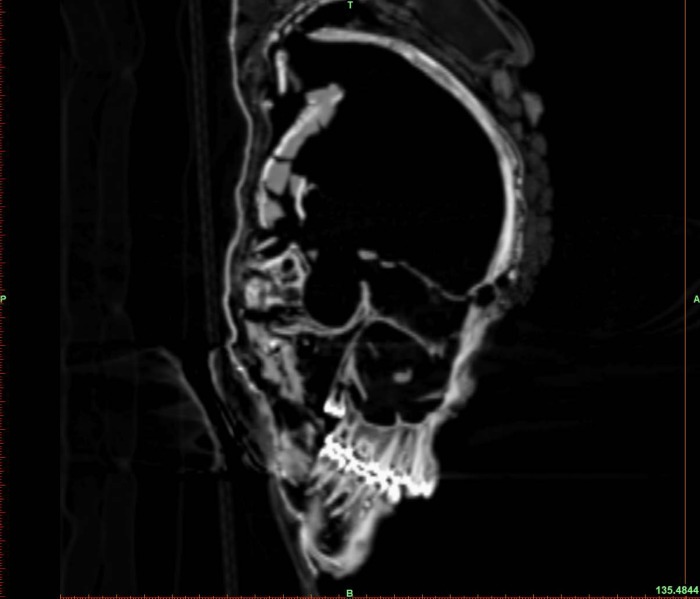
Sagittal CT view of the skull, showing the development state of the teeth.